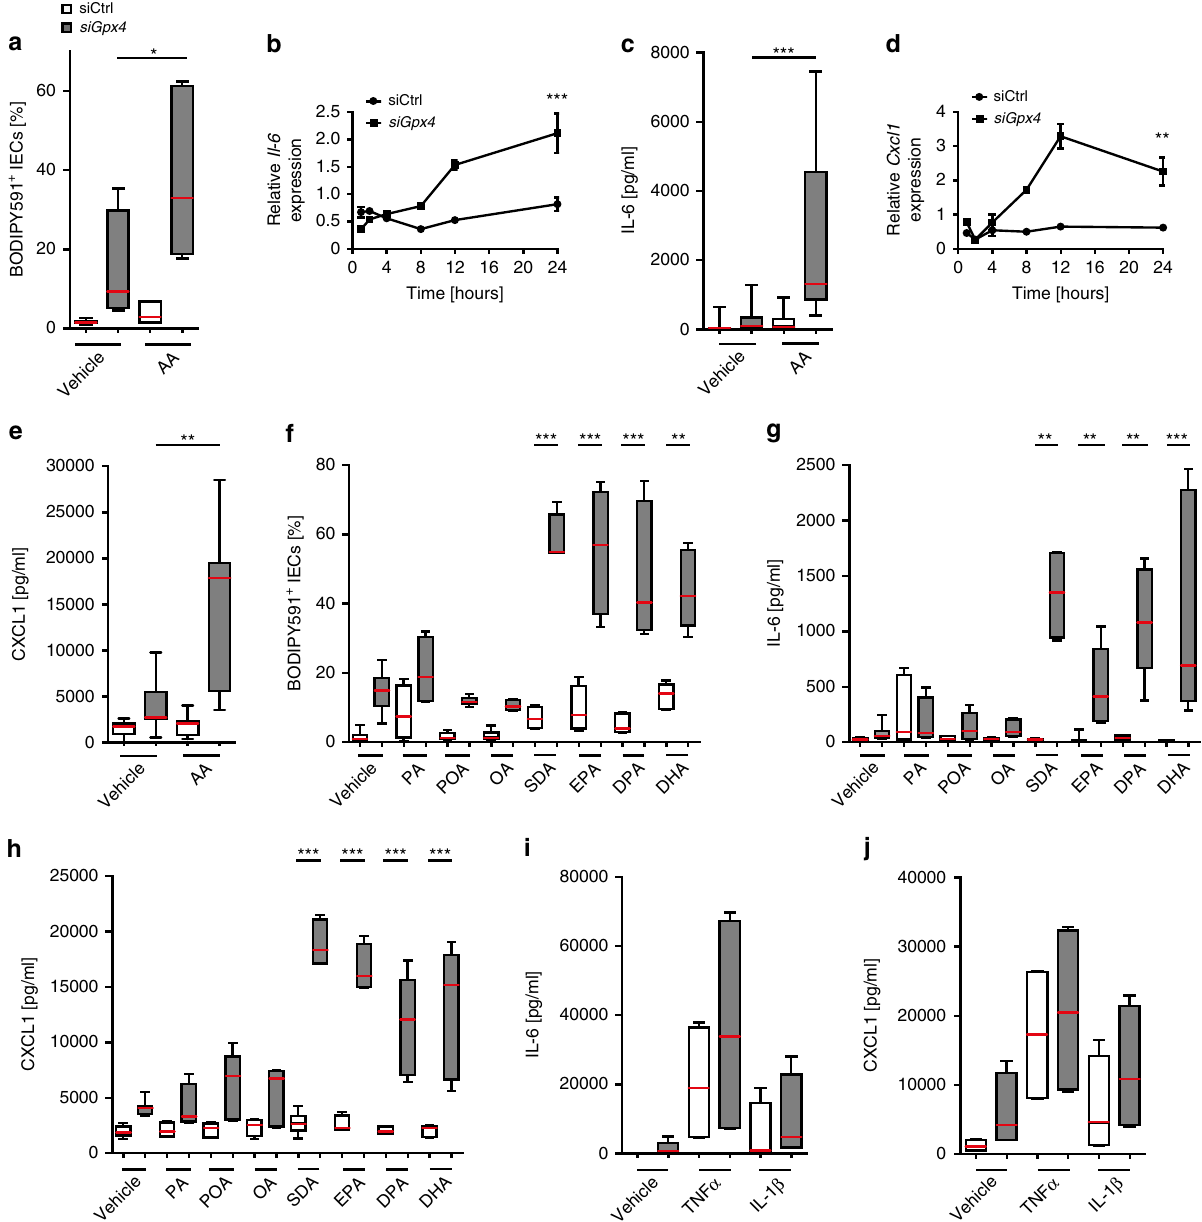
Fig. 2 PUFAs trigger epithelial LPO and an in fl ammatory response restricted by GPX4. a LPO quanti fi cation by fl ow cytometry of BODIPY581/591 C11 + - labeled IECs stimulated with arachidonic acid (AA) for 24 h ( n = 6 biologically independent experiments). * P = 0.0183. b, c Quanti fi cation of IL-6 expression from siGpx4 and siCtrl IECs over a course of AA stimulation determined by qPCR ( n = 4 biologically independent experiments), *** P <0.001 ( b ), and after 24 h by ELISA ( n = 12 for vehicle and n = 24 for AA biologically independent experiments). *** P < 0.001 ( c ). d, e Quanti fi cation of CXCL1 expression from siGpx4 and siCtrl IECs over a course of AA stimulation determined by qPCR ( n = 3 biologically independent experiments). ** P = 0.001 ( d ) and after 24 h by ELISA ( n = 12 for vehicle and n = 24 for AA), ** P = 0.0031 ( e ). f LPO quanti fi cation by fl ow cytometry of BODIPY581/591 C11 + -labeled IECs stimulated with the saturated fatty acid palmitic acid (PA), monounsaturated fatty acids palmitoleic acid (POA) and oleic acid (OA) and polyunsaturated fatty acids stearidonic acid (SDA), eicosapentaenoic acid (EPA), docosapentaenoic acid (DPA) and docosahexaenoic acid (DHA) for 24 h ( n = 4 – 12 biologically independent experiments) For all: *** P < 0.001 and ** P <0.01 ( g, h ). Quanti fi cation of IL-6 and CXCL1 expression from siGpx4 and siCtrl IECs stimulated with PA, POA, OA, SDA, EPA, DPA, and DHA for 24 h by ELISA ( n = 4 – 11 biologically independent experiments). *** P < 0.001 and ** P < 0.01. i, j Quanti fi cation of IL-6 and CXCL1 production from siGpx4 and siCtrl IECs stimulated with TNF α or IL-1 β for 24 h by ELISA ( n = 4 biologically independent experiments). For panel ( a ), ( c ) and ( e – j ) data are presented as boxblot with median and interquartile range (25th and 75th). The whiskers represent minimal and maximal values. For panel ( b ) and ( d ) data presented as mean ± SEM. For panel ( a – j ) to ( j ) one-way ANOVA with Bonferroni multiple comparison test or a Kruskal – Wallis test with Dunn ’ s multiple comparison test was used with the exception of panel ( b ) and ( d ) for which a two- way ANOVA with Bonferroni post-hoc test was used and panel ( f ) and ( g ) for which an unpaired two-tailed Student ’ s t test was used. Source data are provided as a Source Data fi